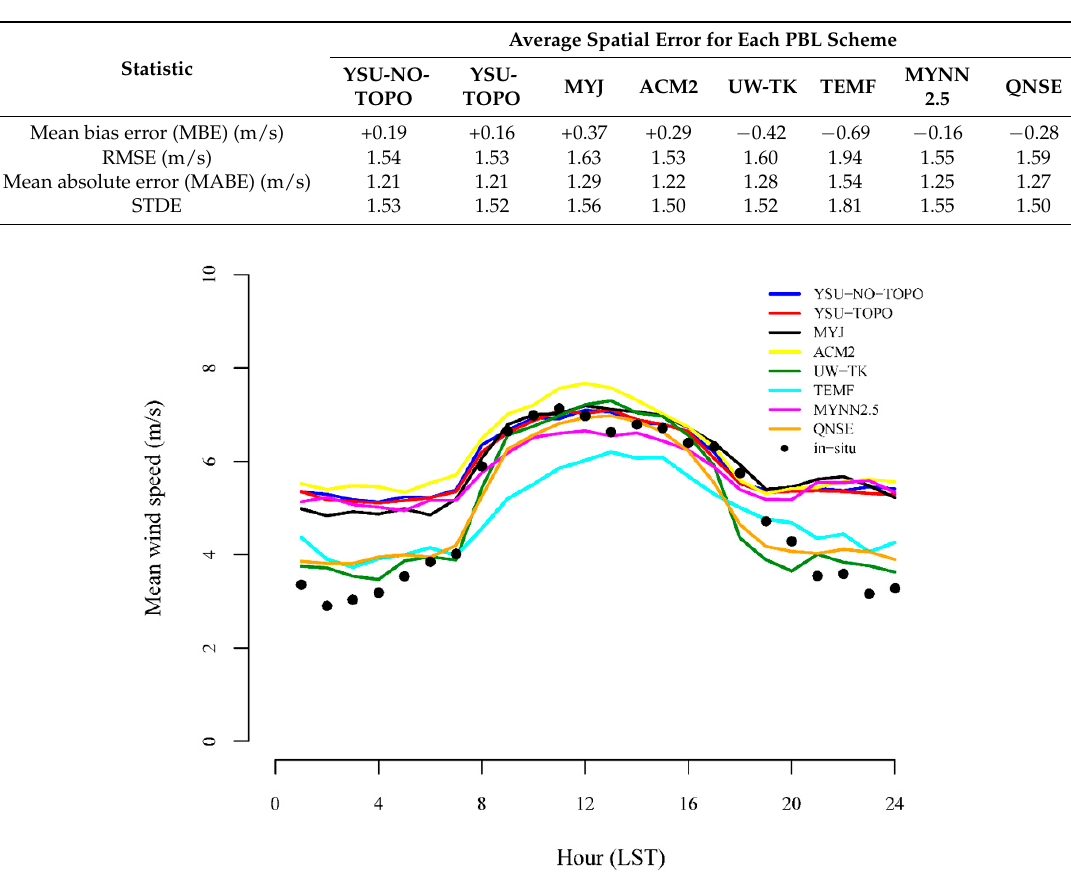
Table 4. Mean spatial error statistics in wind speed at the 10 m height above ground for each PBL scheme. These spatial errors were derived from averaging the corresponding station errors in Tables 3 and 4.